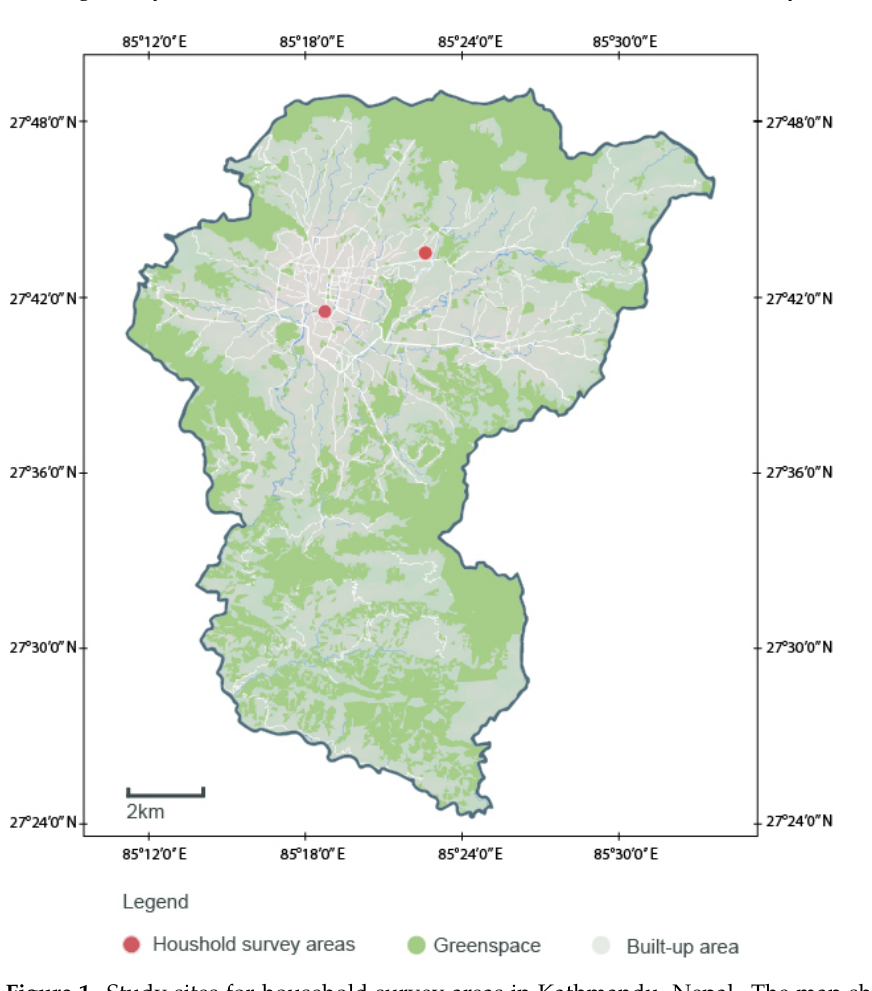
Figure 1. Study sites for household survey areas in Kathmandu, Nepal. The map shows the ad- ministrative boundaries of the Kathmandu agglomeration including Kathmandu, Lalitpur and Bhaktapur districts.